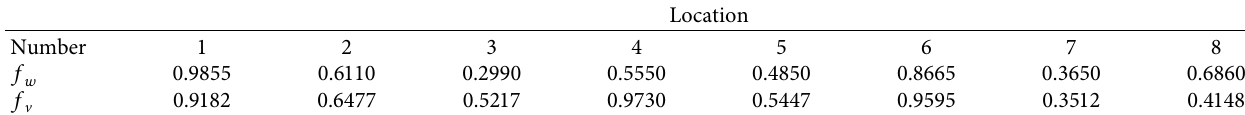
Table 3: Fitness matrix f .